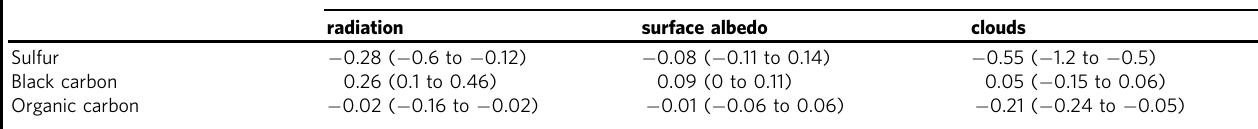
Table 3 Global effective radiative forcings from aerosol interactions with radiation, surface albedo, and clouds for global emissions of sulfur, black carbon, and organic carbon in 2015, relative to a preindustrial atmosphere with no anthropogenic aerosol